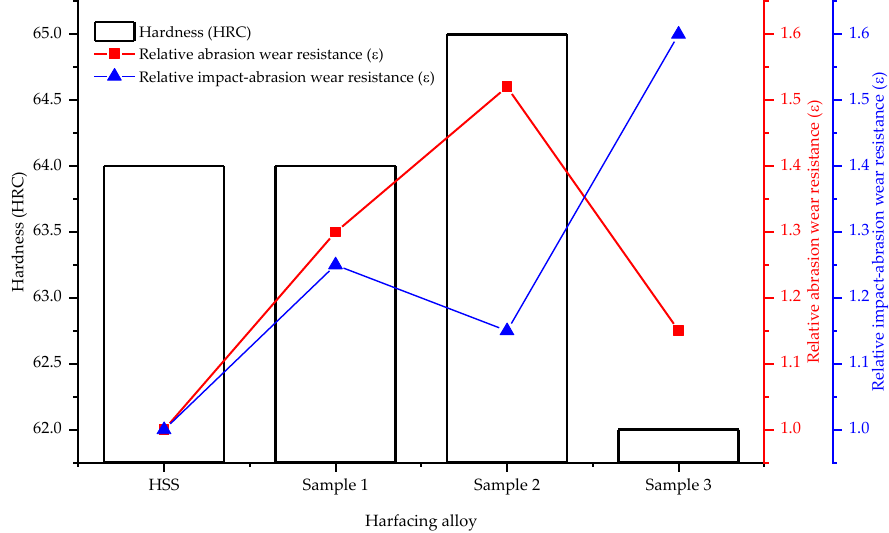
Figure 10. Comparison chart of hardness and wear resistance of experimental hardfacing alloys.